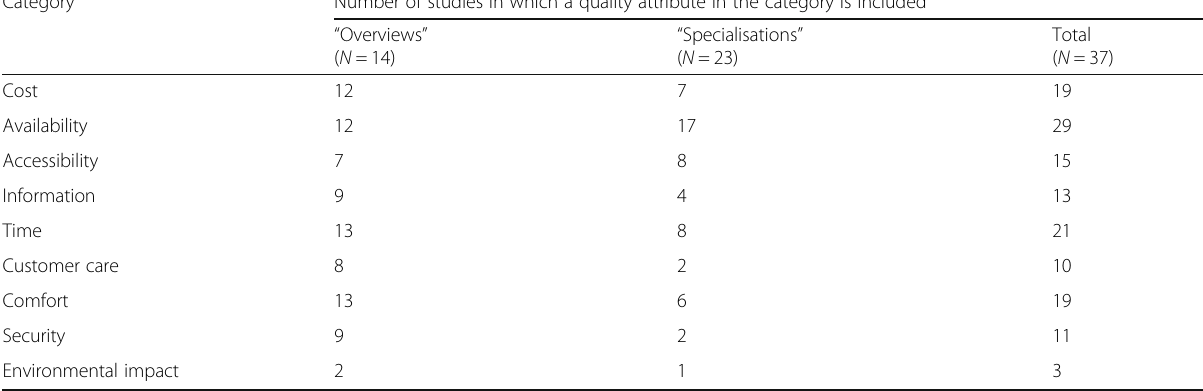
Table 3 Inclusion of quality attribute categories in the reviewed studies Category Number of studies in which a quality attribute in the category is